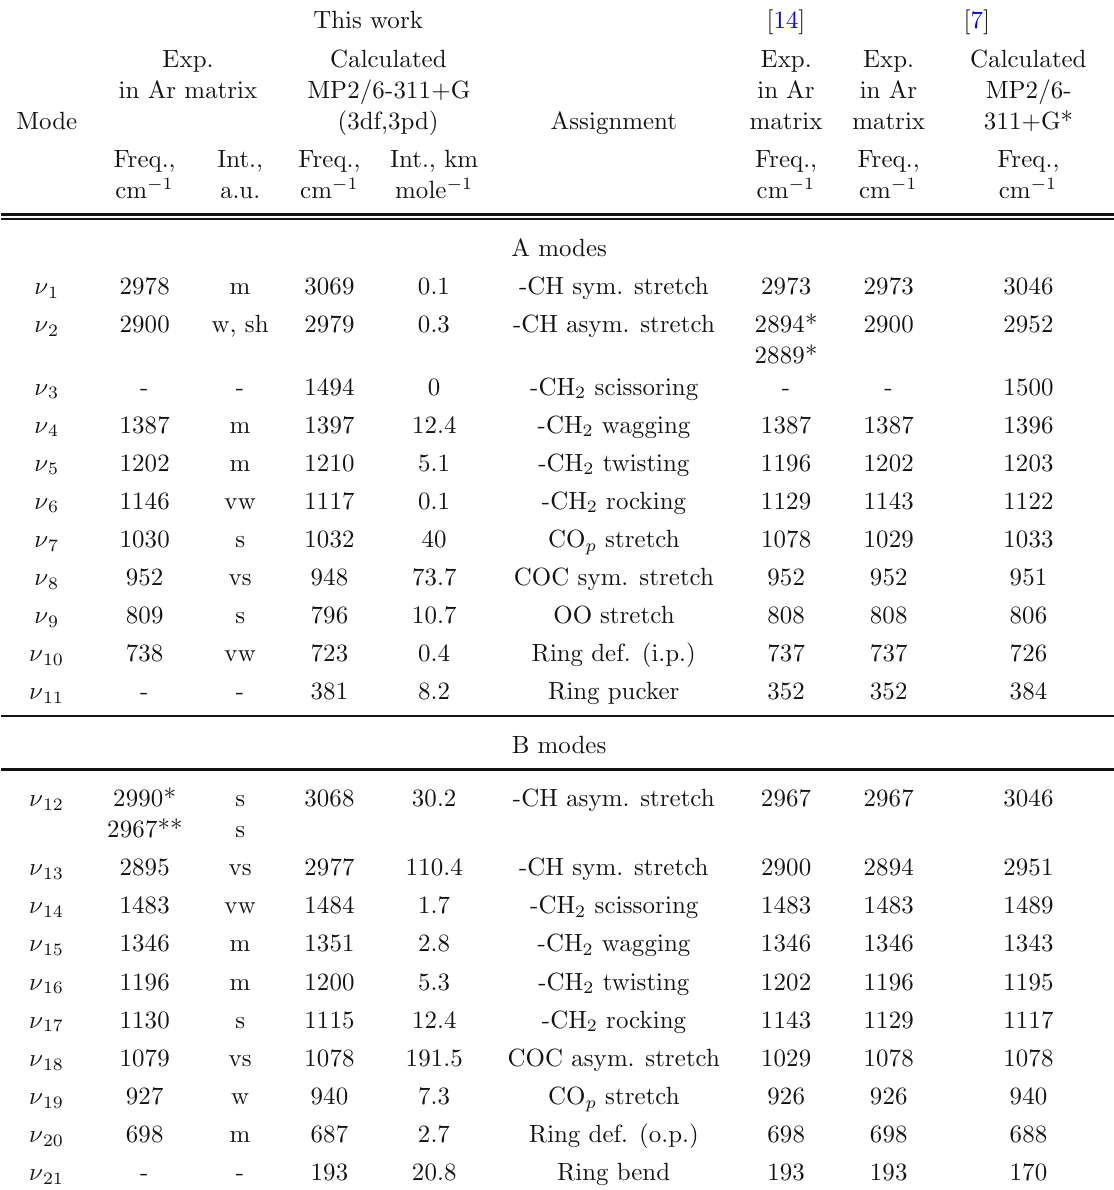
* Fermi resonance between ν 2 and 2 ν 3 ( ν 2 and ν 3 experimental wavenumbers from [9]), *Fermi resonance between ν 12 and 2 ν 8 + ν 18 ( ν 12 , ν 8 and ν 18 experimental wavenumbers from this work), o.p.–out of plane, i.p.–in